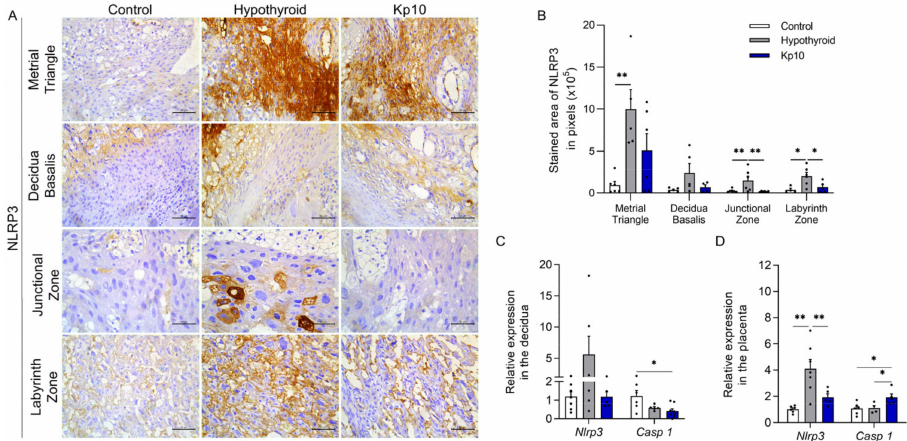
Figure 1. Expressions of NLRP3 and Caspase 1 at the maternal-fetal interfaces of control, hypothyroid, and kisspeptin-10 (Kp10)-treated rats. ( A ) Photomicrographs of the immunohistochemical expres- sion of NLRP3 at the maternal-fetal interface (streptavidin-biotin-peroxidase; Harris hematoxylin; Bar = 50 µ m). ( B ) Immunostaining area in pixels of NLRP3 expressions in the metrial triangle, basal decidua, junctional zone, and labyrinth zone (mean ± SEM; n = 8). ( C ) Relative gene expression of Nlrp3 and Casp 1 in the deciduae (mean ± SEM; n = 8). ( D ) Relative gene expressions of Nlrp3 and Casp 1 in the placenta (mean ± SEM; n = 8). Significant differences were determined by post hoc ANOVA SNK, * p < 0.05, ** p < 0.01. Kp10 = daily treatment with Kp10; DG = day of gestation.